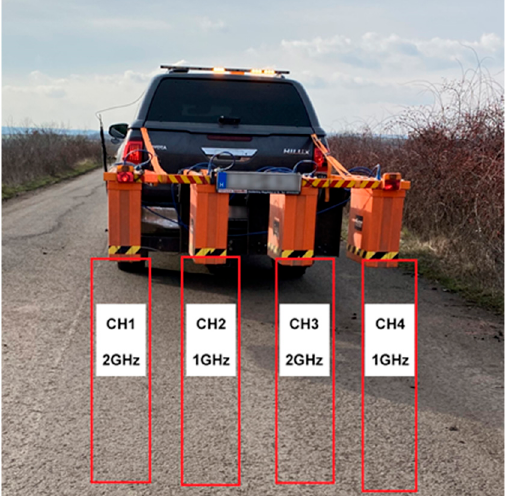
Figure 15. GPR equipment used in this project (source: RODEN Engineering Office).